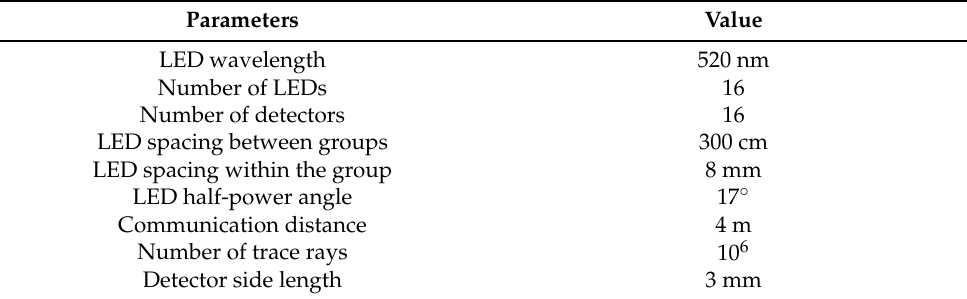
Table 1. ZEMAX optical path simulation